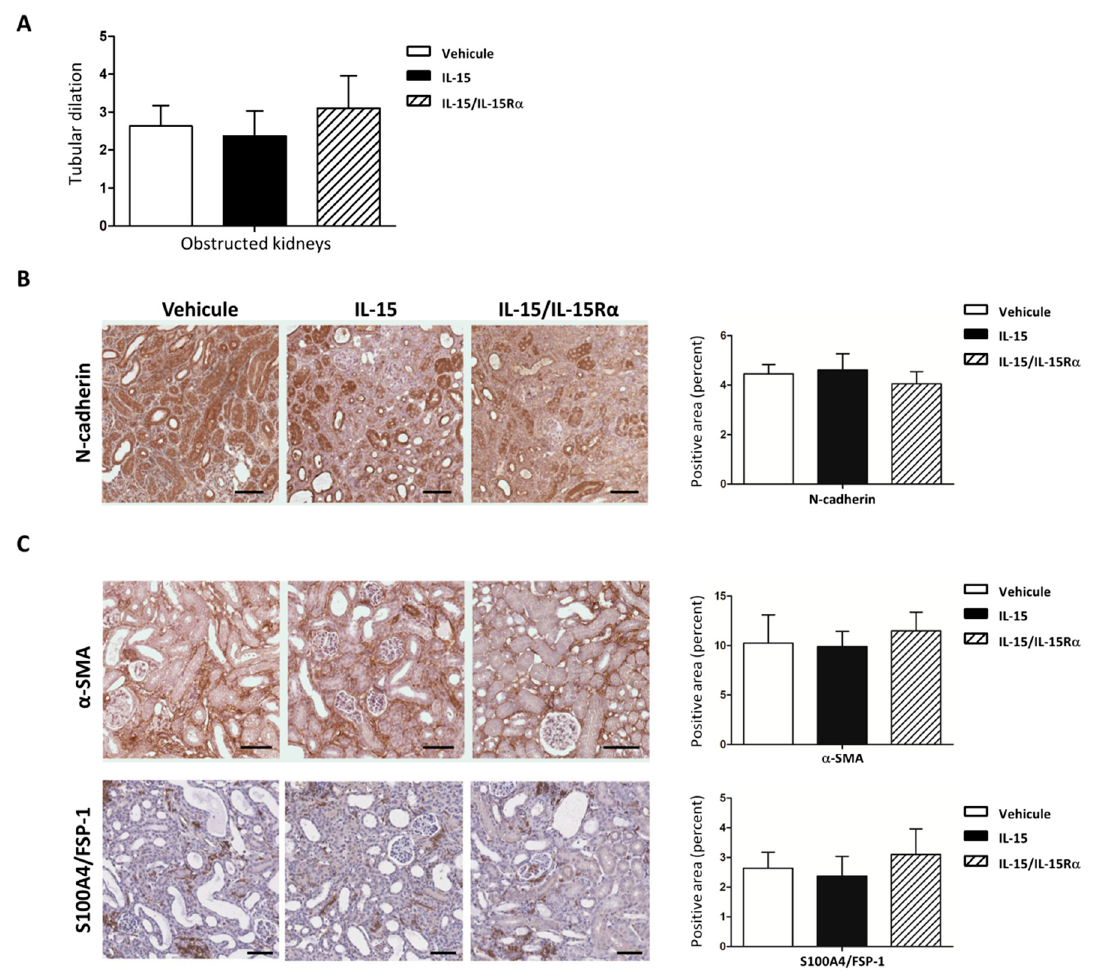
Figure 4. Neither IL-15 nor IL-15/IL-15R α treatments modulated mesenchymal markers in 8 d-post obstructed kidneys. ( A ) Tubular dilation was quantified by two different experimenters as follows in a double-blind manner; score 0: 0% of dilated tubules, score 1: 0–25%, score 2: 25–50%, score 3: 50–75%, score 4: 75–100%. Data are means ± SEM. ( B , C ) Both IL-15 and IL-15/IL-15R α treatments did not modify the mesenchymal markers expression in the renal cortex during UUO. Left, Representative IHC staining for n -cadherin, α -SMA, and S100A4/FSP-1 in the renal cortex of vehicle, IL-15, and IL-15/IL-15R α -treated mice. Scale bars, 50 µm. Right, Bar charts represent quantification of the positive area by histomorphometry. Values are means ± SEM from seven mice by group.